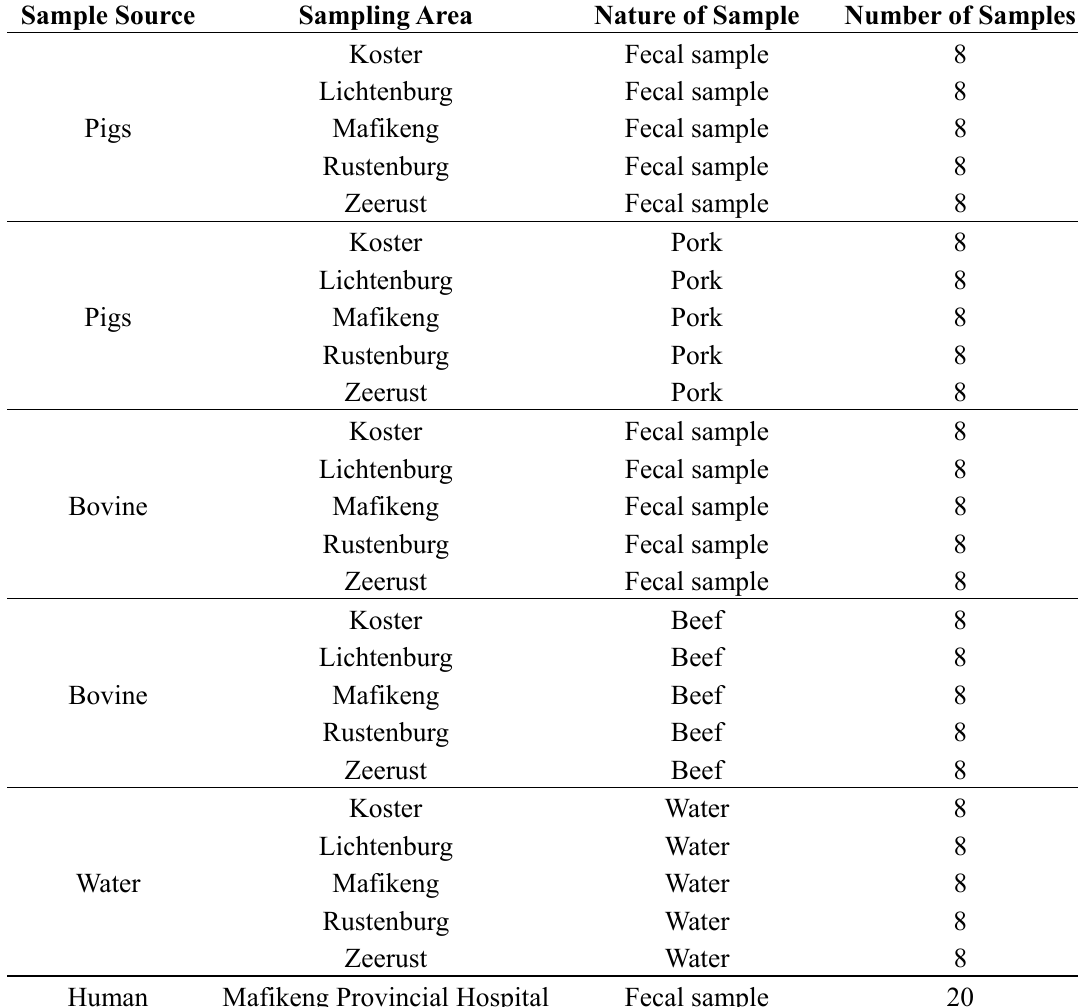
Table 2. Area of collection, source, nature and number of samples collected during the